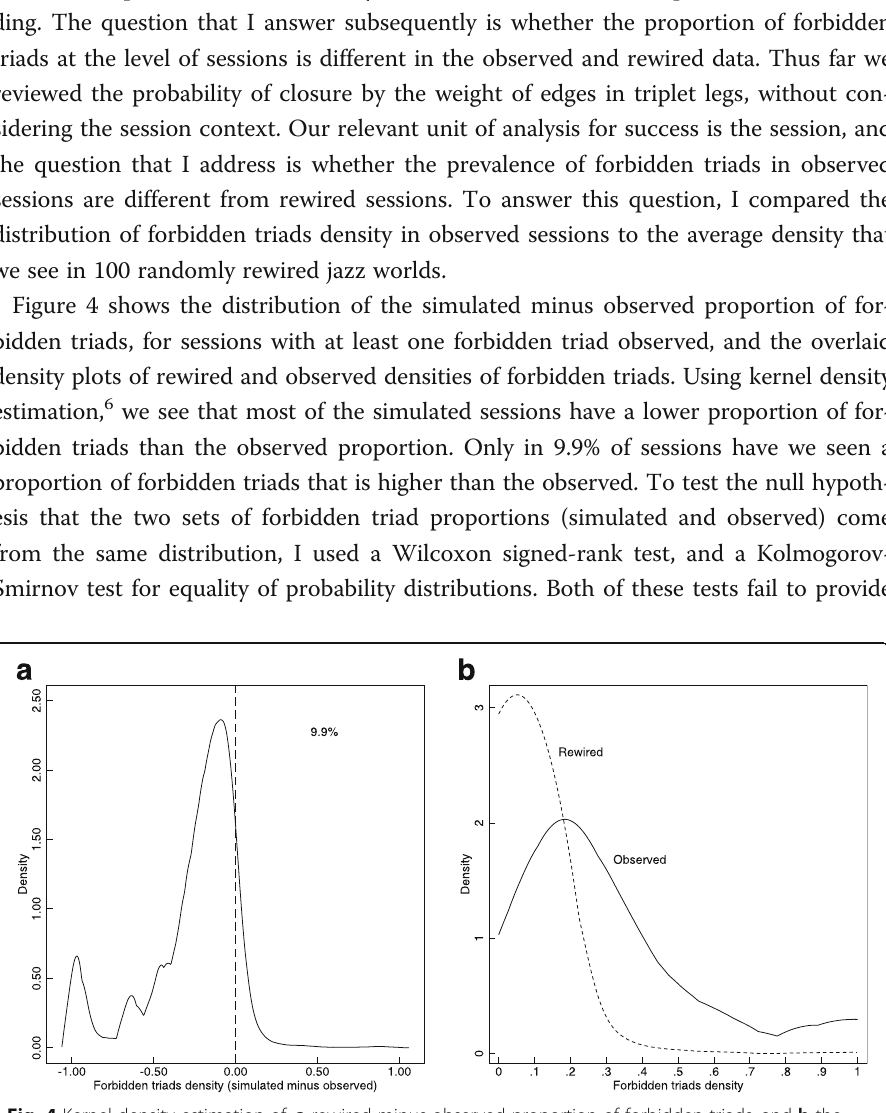
Fig. 4 Kernel density estimation of: a rewired minus observed proportion of forbidden triads, and b the mean rewired proportion and the observed proportion of forbidden